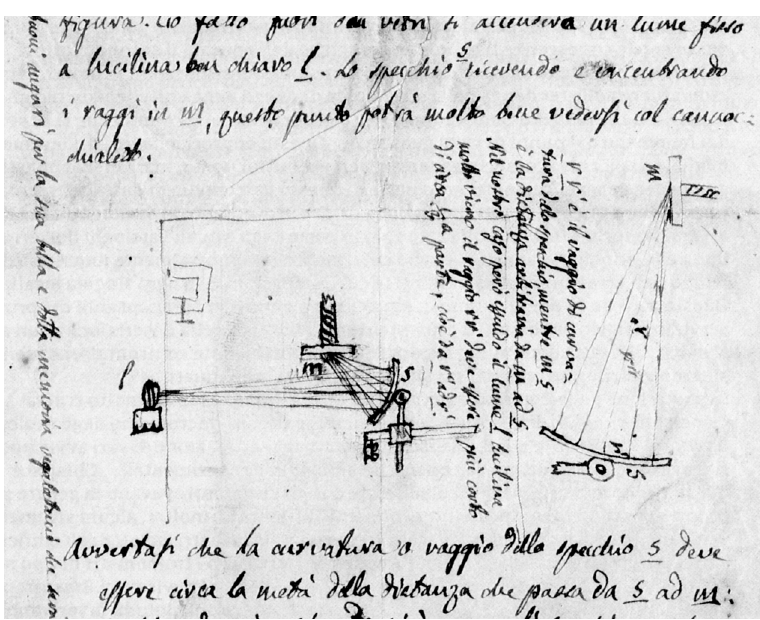
Fig. 2. Detail of a letter by G. Cavalleri to T. Bertelli, [Monza] 24th [March] 1874, in which the brother gives some suggestions on the illumination system of the tromometer measuring apparatus (Historical Archives of Barnabites,